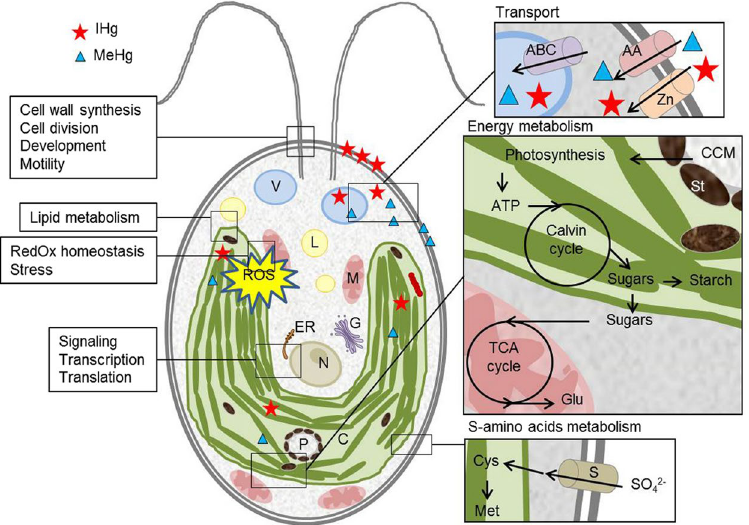
Figure 4. Schematic representation of cellular toxicity pathways and tolerance responses, as derived from uptake, transcriptome and physiological effects in C. reinhardtii exposed 2 h to IHg and MeHg (AA: amino acid transporter; ABC: ABC transporter; C: chloroplast; CCM: carbon concentrating mechanism; Cys: cysteine; L: lipid bodies; ER: endoplastic reticulum; G: golgi; Glu: glutamate; M: mitochondria; Met: methionine; N: nucleus; P: pyrenoid; S: S transporter; St: starch; V: vacuole; Zn: metal